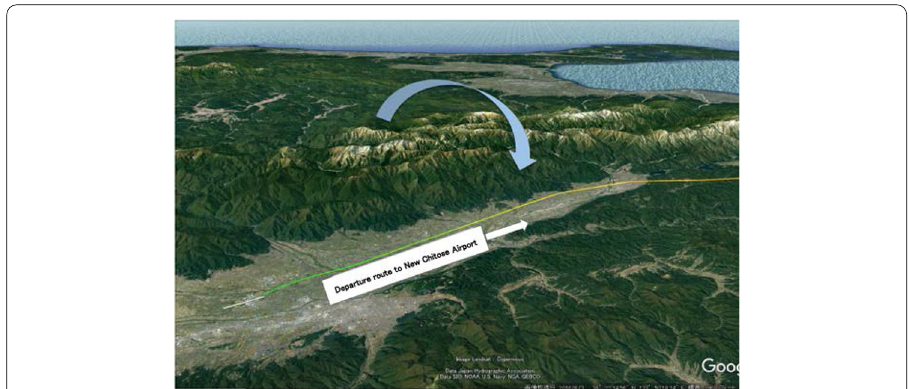
Fig. 2 Impact of mountain waves on flights departing from Matsumoto